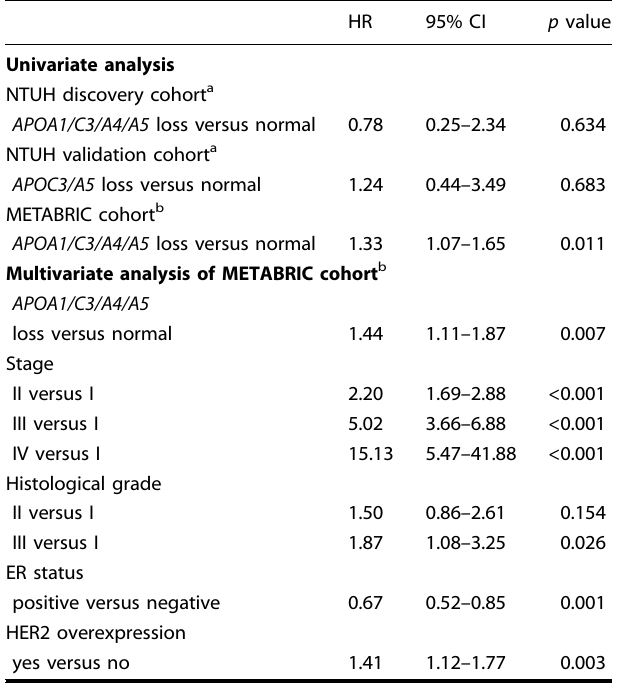
Table 3. Association of breast cancer outcome and APOA1/C3/A4/A5 or APOC3/A5 loss: the univariate analyses in the three cohorts and a multivariate Cox ’ s proportional hazards model in METABRIC